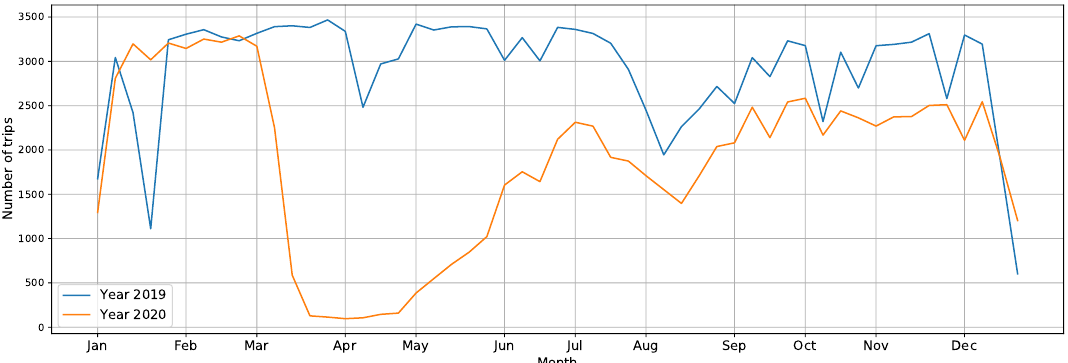
Figure 5. Number of weekly trips made with the SMTS during 2019 and 2020. Blue and orange line graphs represent the number of trips made during 2019 and 2020, respectively.